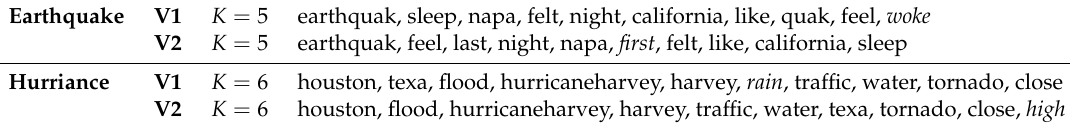
Table 8. Top 10 terms in the disaster-related topic (i.e., highest probability in the topic-term matrix β ) for both datasets based on the best value for K for the two automated variants GLDA V1 and V2. The ordering corresponds to the term probability. Terms that are unique for one variant are highlighted in